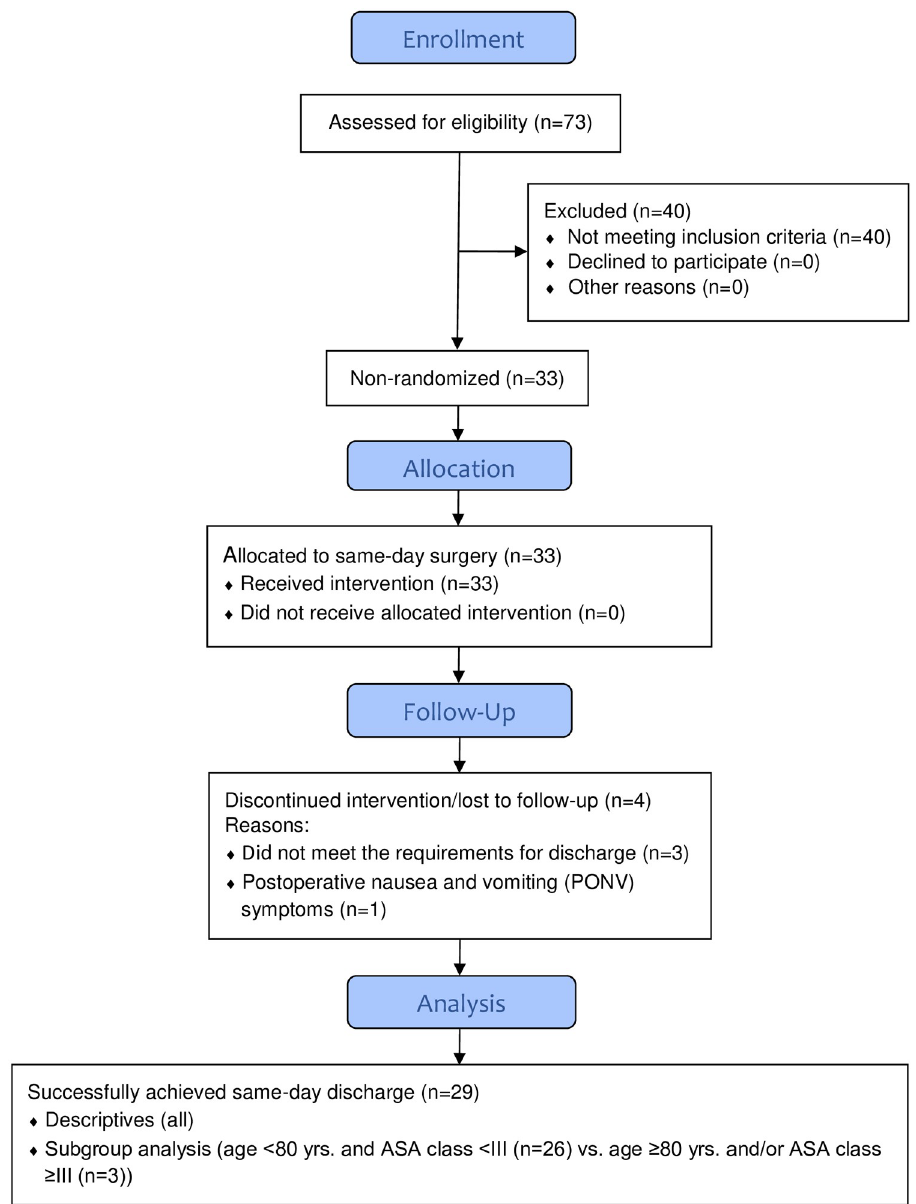
Fig 2. TREND flow